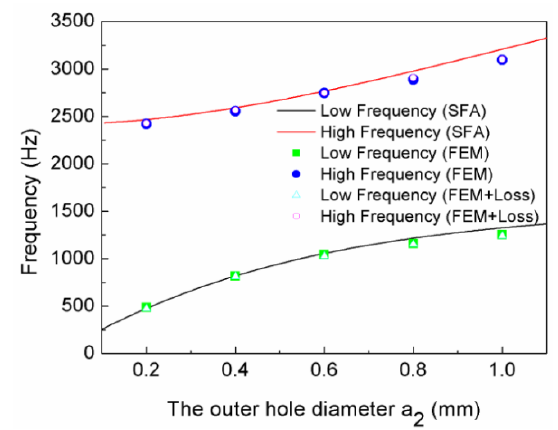
Figure 7. The relationship curves of the outer hole diameter and resonant frequencies.